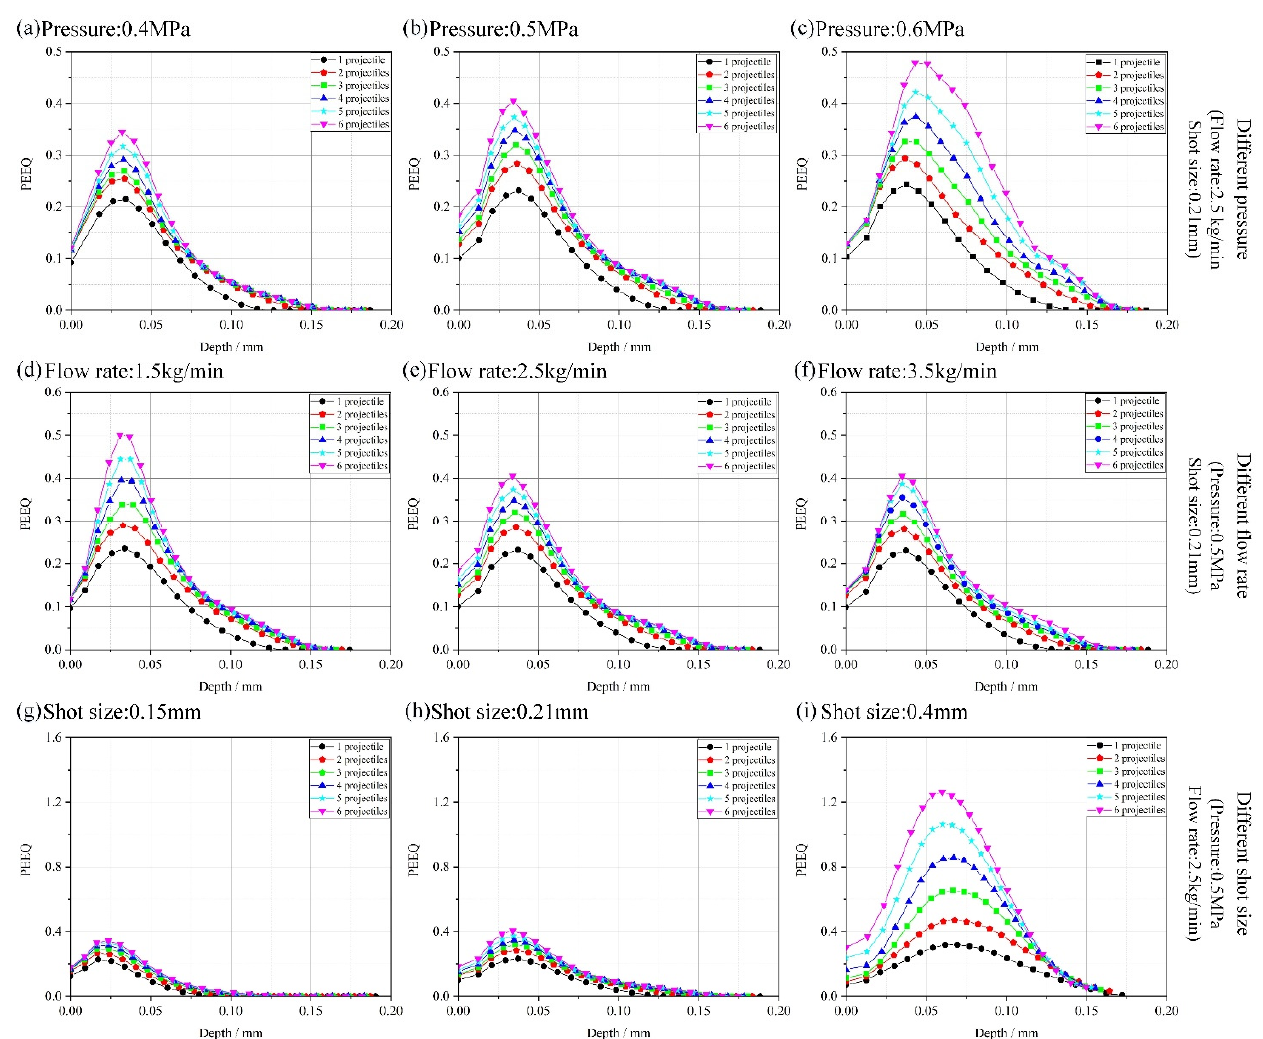
Figure 8. The effect of impact times on equivalent plastic strain distribution of coatings under different conditions: ( a – i ) corresponds to the conditions shown in Table 2.